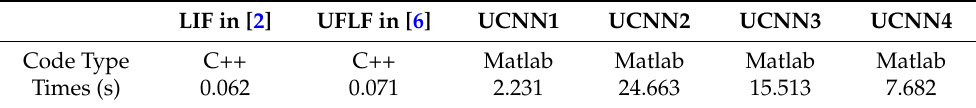
Table 10. Feature extraction times of different single features per image scene.